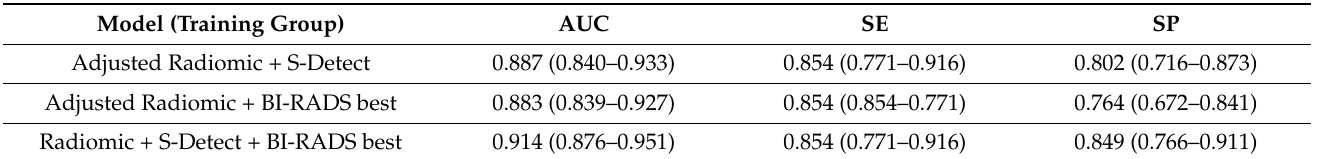
Table 4. Performance of adjusted radiomic model with S-Detect, with BI-RADS. Evaluation and together with S-Detect and BI-RADS evaluation; dataset of N = 209 patients.